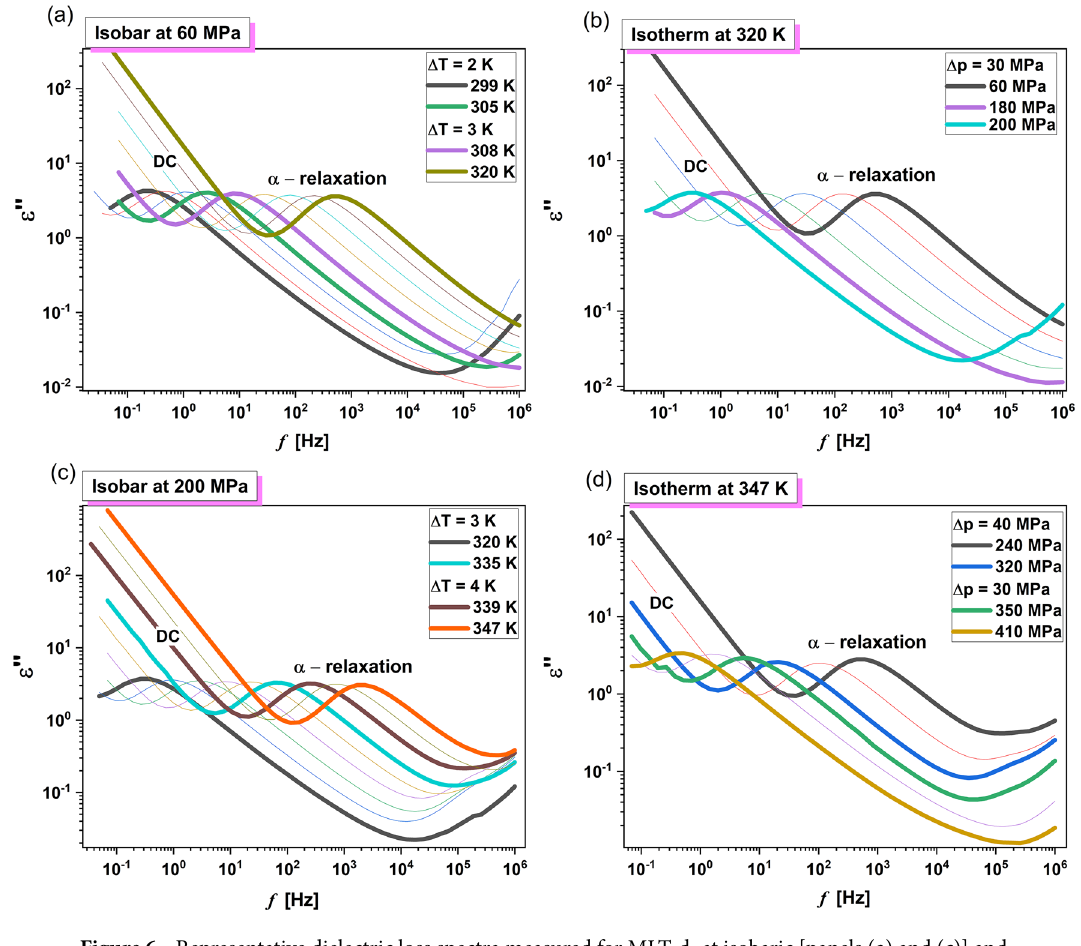
Figure 6. Representative dielectric loss spectra measured for MLT-d 2 at isobaric [panels ( a ) and ( c )] and isothermal [panels ( b ) and ( d )] conditions.